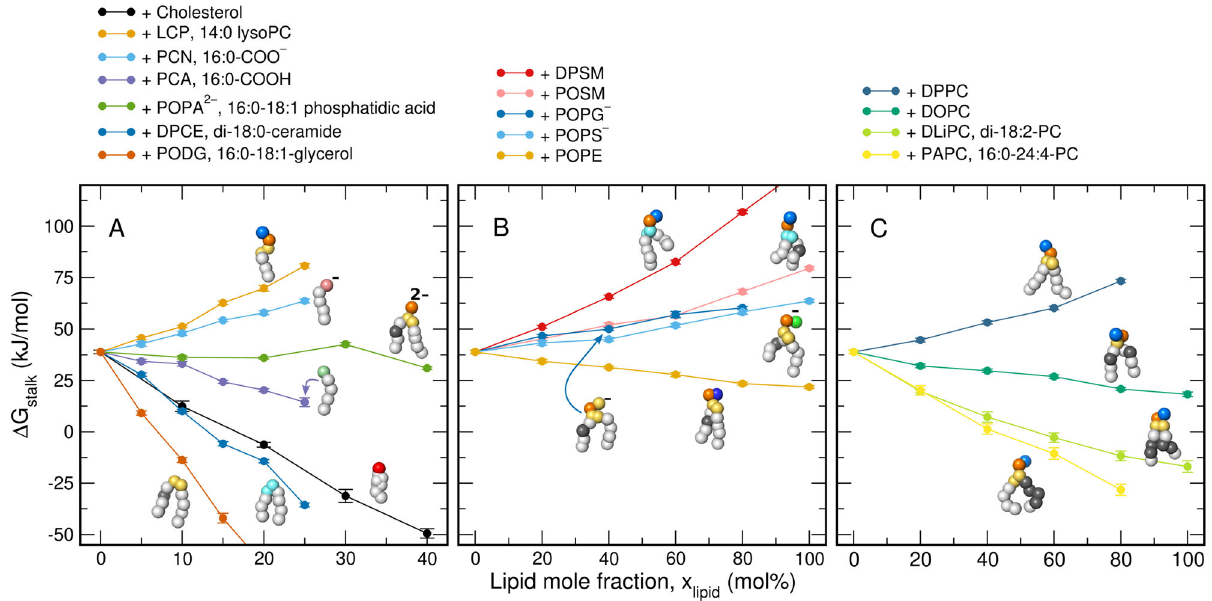
Fig. 5 Stalk free energies for binary lipid mixtures. Free energies of stalk formation Δ G stalk for binary lipid mixtures of POPC plus one additional type of lipid. 0 mol% correspond to pure POPC. The additional lipids are A cholesterol, lysoPC, fatty acids, phosphatidic acid, ceramide, diacylglycerol, B sphingolipids, phosphatidylglycerol, -serine, and -ethanolamine, C phosphatidylcholine with increasing tail unsaturation. For color code, see legend. Martini beads are colored with the scheme used for Fig. 4 and as follows: hydroxyl (red), carboxylate (pale red), carboxyl (pale green), sphingosine (cyan). Error bars computed by bootstrapping denote 1 SE. Source data are provided as a Source Data fi